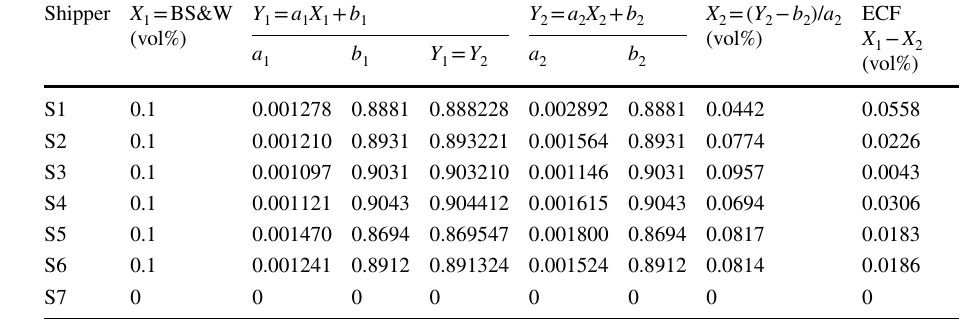
Shipper X 1 = BS&W